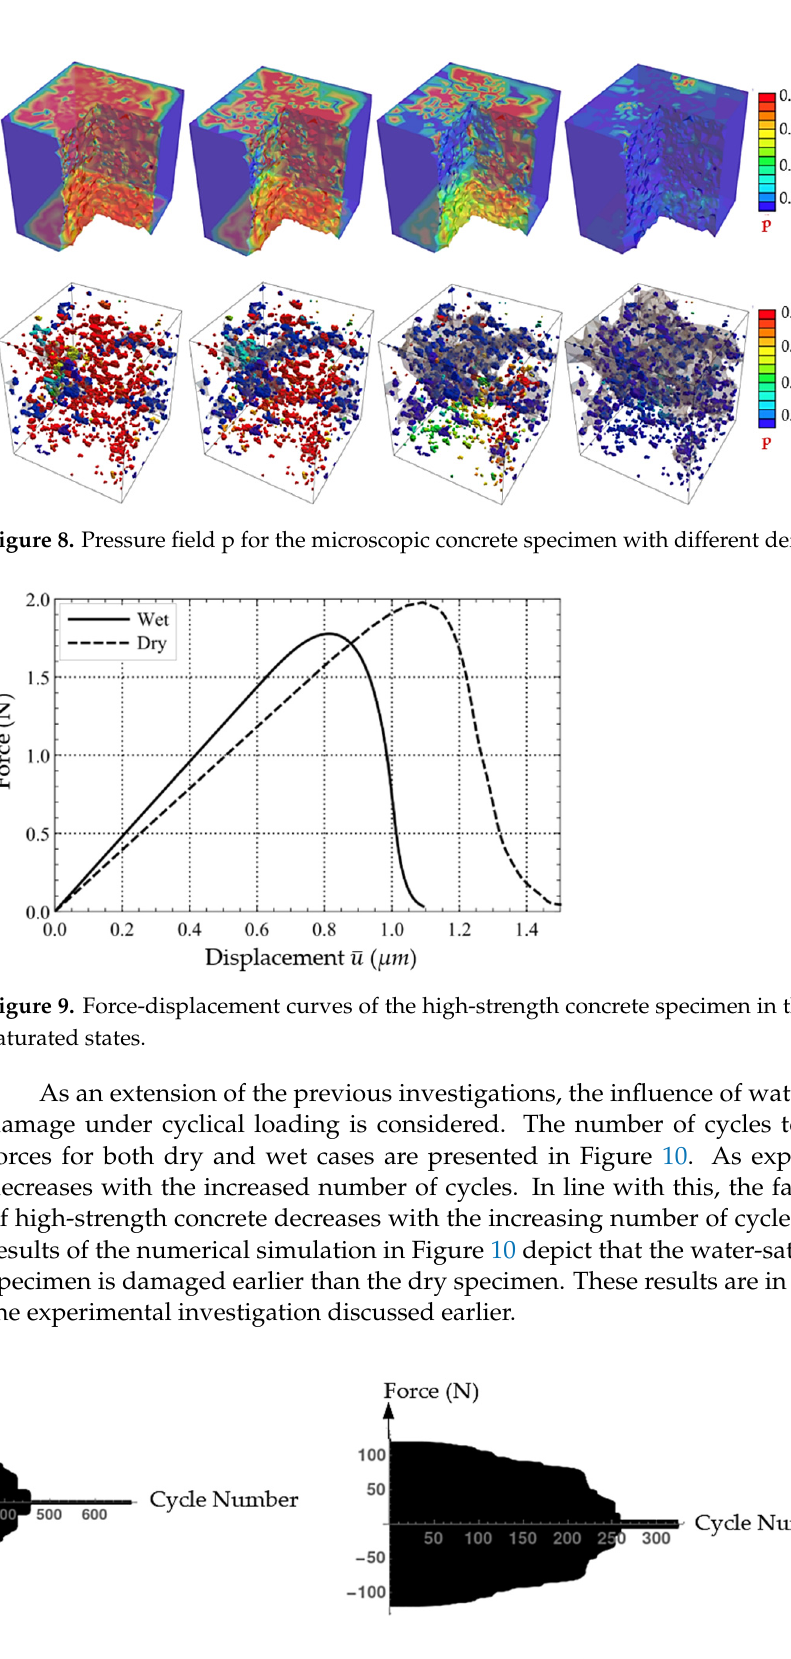
( c ) Figure 7. Finite element discretization: singularities inside the microstructure geometry scanned ( a ); two different high-strength concrete meshes ( b , c ). Next, the pressure evolution at a cut inside the high-strength concrete specimen is provided in Figure 8 (first row). The numerical solution results in the prediction of the crack phase-field 𝑑 that is initiated and propagated in random directions (and so merging) inside the cement matrix until complete failure. It was noticed from the results that the